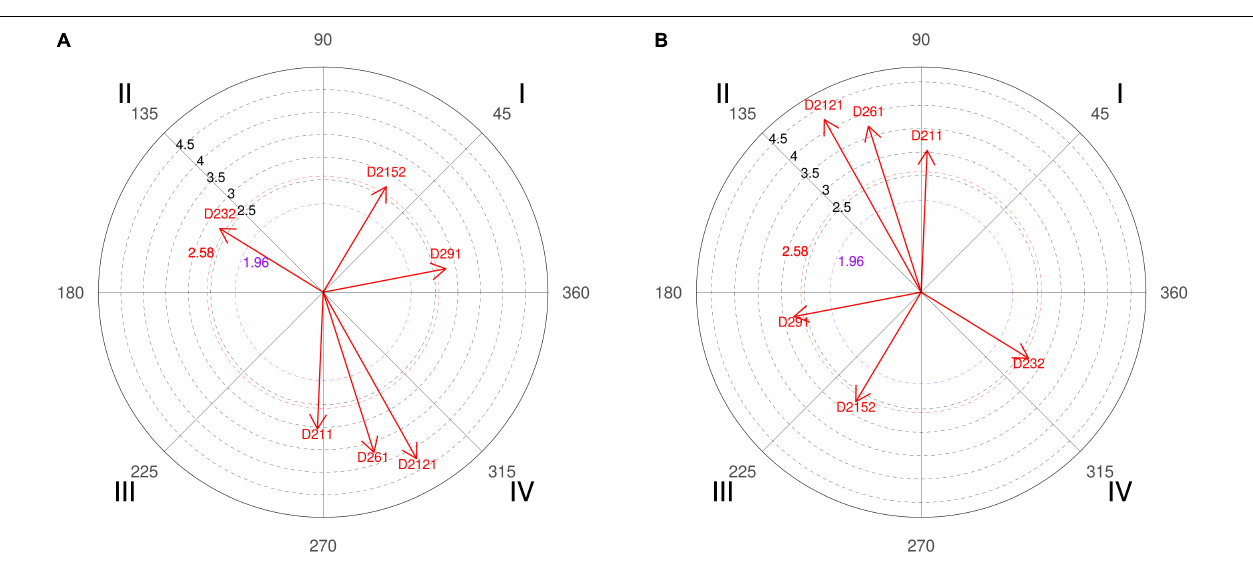
FIGURE 5 | (A,B) Relationship of conditioned behaviors that present a significant relationship with the focal behaviors “favorable evaluation” and “unfavorable evaluation” analyzing question 10 of the in-depth interviews. In “favorable evaluation,” a total of six significant vectors were detected, and in “unfavorable evaluation,” a total of six significant vectors were